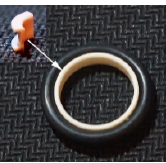
Figure 2. Photograph of Cap-seal.